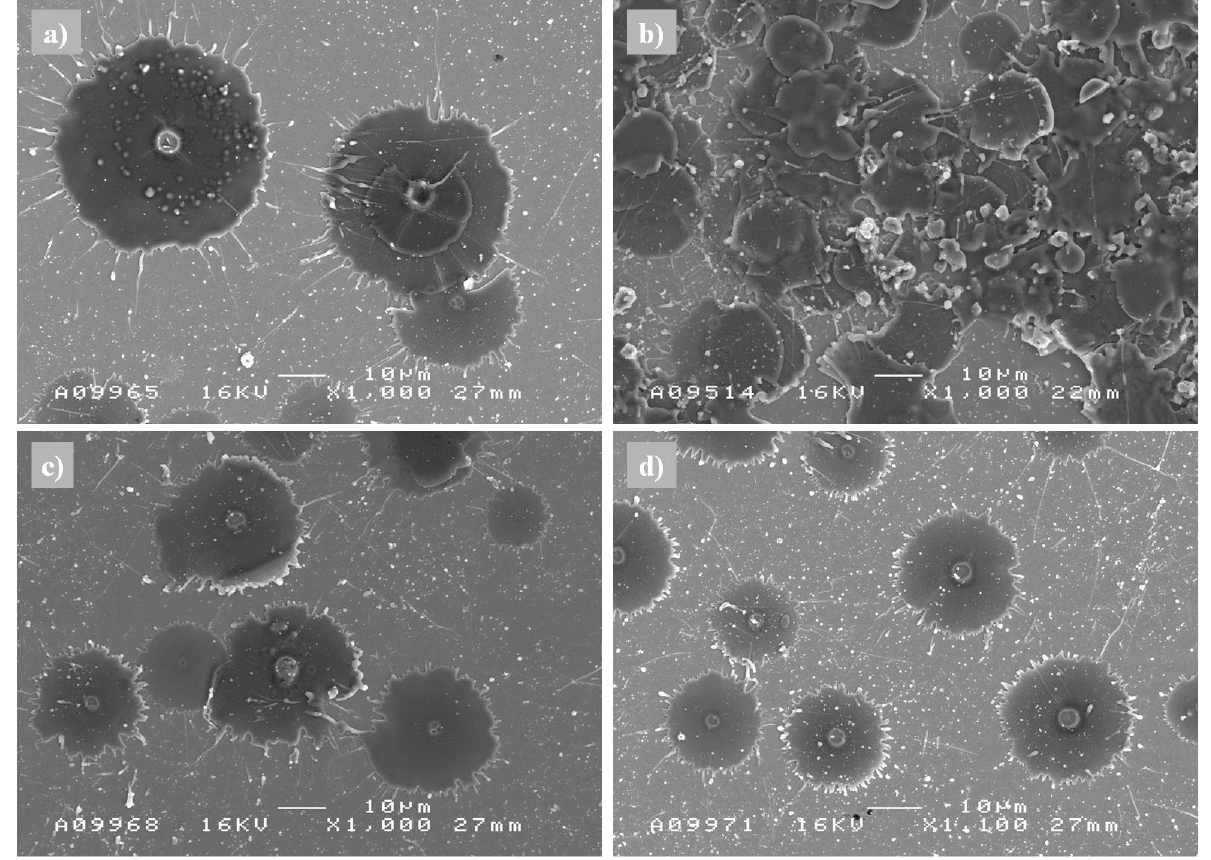
Figure 4. In the SEM figures of splats different melting, flattening and splashing behavior of HV2000 (Praxair) sprayed Al have been ( a ) 776 L/min H stand-off distance, ( b ) 776/272/20 (2.85) 200 mm, ( c ) 699/349/20 (2.00) 150 mm, and ( d ) 747/301/20 (2.48) 150